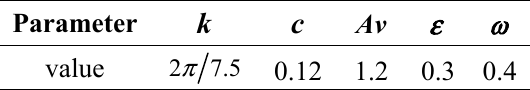
Table 3. Parameters of the water flow field.